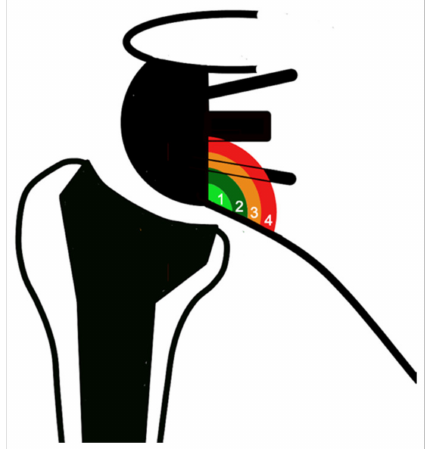
Figure 1. Notching classification according to Sirveaux et al. [6]: grade 1—defect confined to the pillar; grade 2—defect reaching the lower screw; grade 3—defect over the lower screw; grade 4—defect extended under the